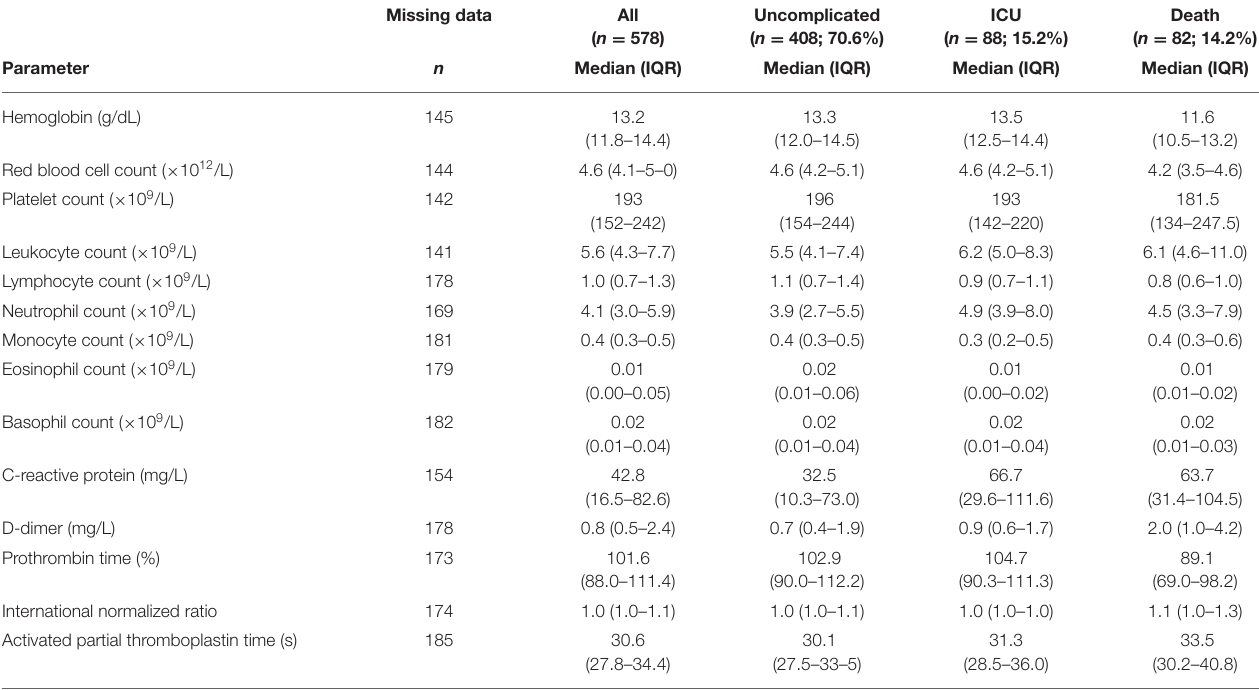
TABLE 3A | Laboratory findings at admission (retrospective cohort).